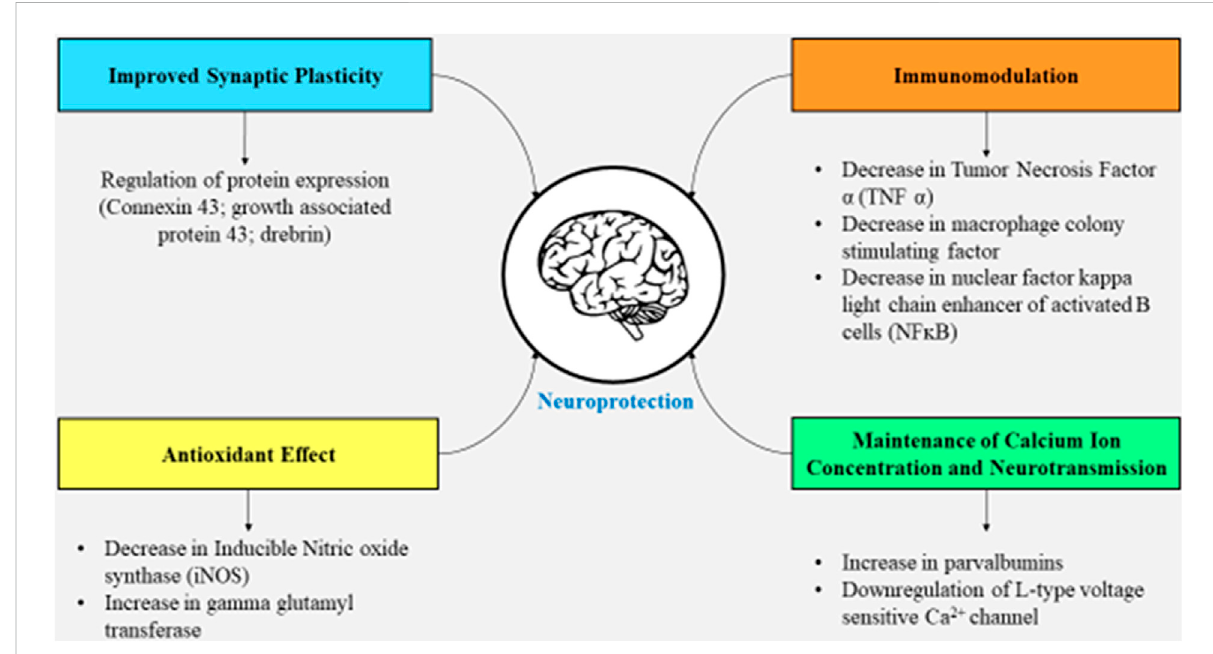
FIGURE 2 Effects of vitamin D on the brain facilitating synaptic plasticity, immunomodulation, neurotransmission, and a decline in oxidative